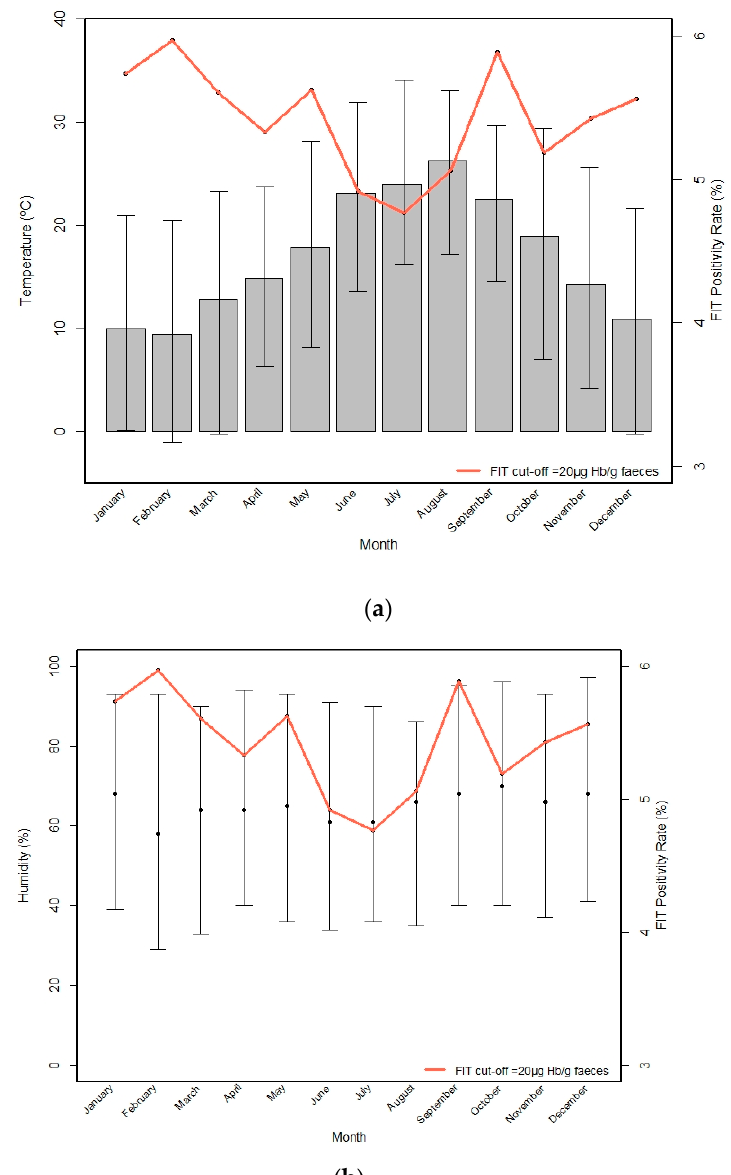
Figure 2. Monthly fluctuations in positivity for the FIT over the year (red line) and the monthly temperature ( a ) and humidity ( b ) during the study period, respectively. The extremes in the confidence intervals represent the minimum and maximum temperature of each month. Table 2. Variation in hemoglobin (ng/mL) concentration according to the quarter of the year when the FIT was performed.